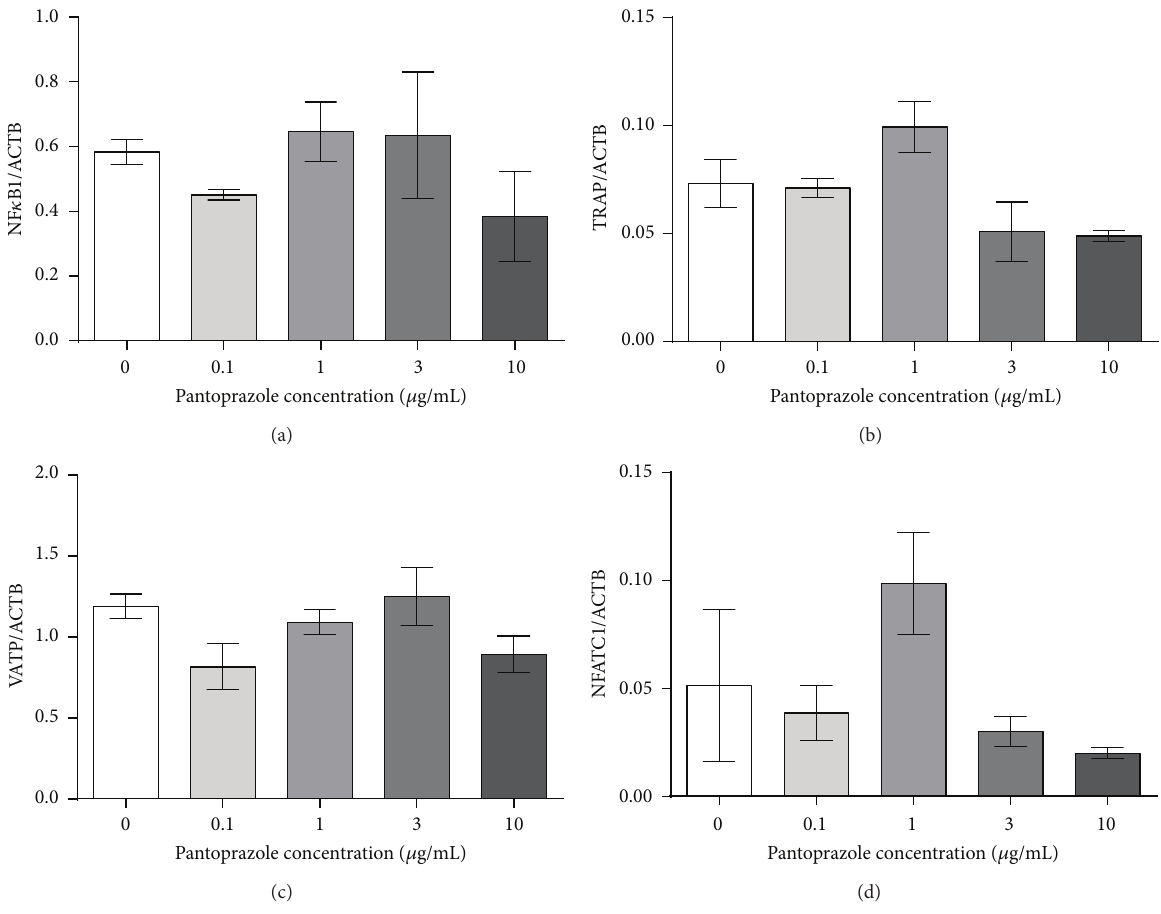
Figure 6: Gene expression analysis of NF 𝜅 B (a), TRAP (b), VATP (c), and NFATC1 (d) was performed after 7 days of stimulation with pantoprazole ( 𝑁 = 4 , 𝑛 = 2 ). The results were normalized to the housekeeping gene 𝛽 -actin (ACTB). Shown are column bar graphs of means ±